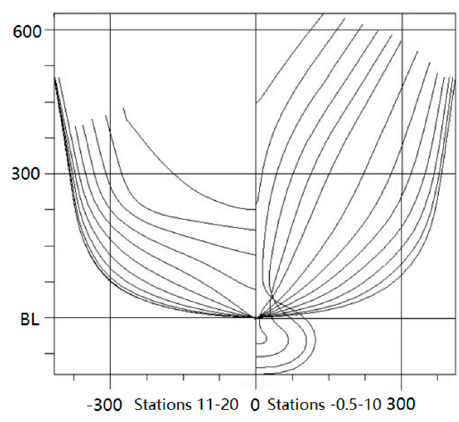
Figure 3. The schematic diagram of the damaged ship.